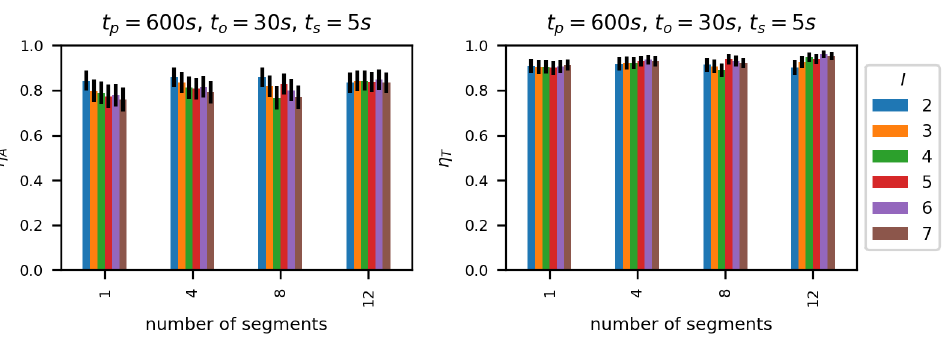
Figure 13. Number of segments impact on η A and η T metrics—DLR-LEM.